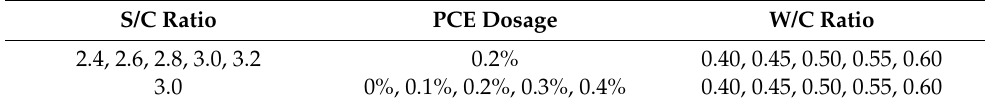
Table 2. Mixture ratio of mortar samples.